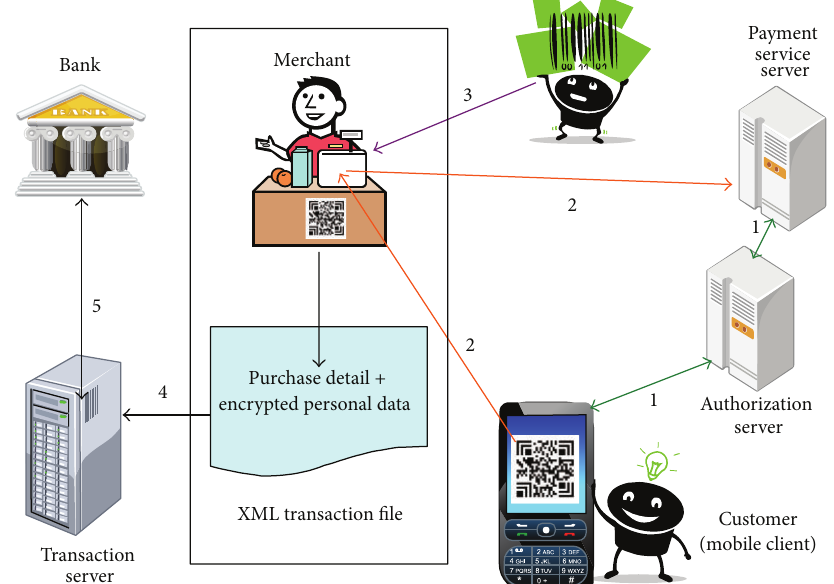
Figure 1: The business scenario of the payment mechanism.